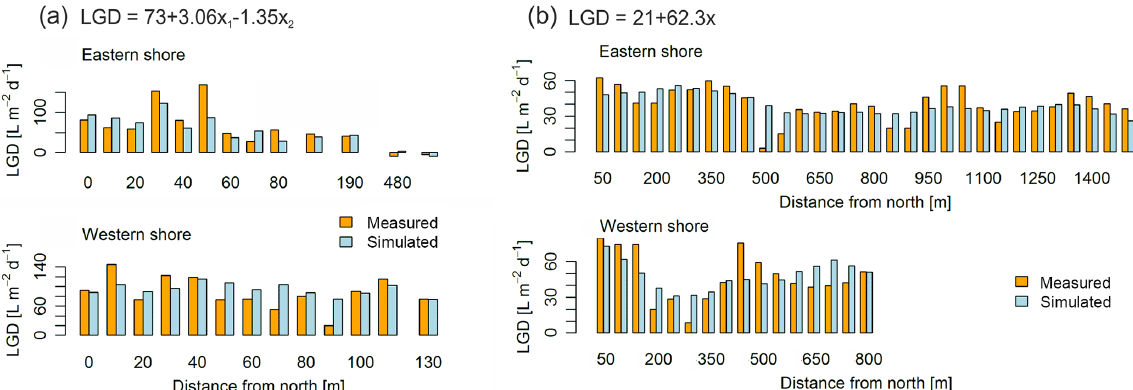
Figure 9. Observed and calculated LGD distribution along the shoreline. (a) Small-scale patterns predicted using a multiple regression model with coarse sand and fine sand as predictors and (b) large-scale patterns predicted by the linear model based on groundwater gradients derived from regression kriging from zone zi 25m . Regression equations for both small- and large-scale patterns are included in the upper right corner. In the small-scale variability equation, x 1 stands for the fraction of coarse sand and x 2 for fine